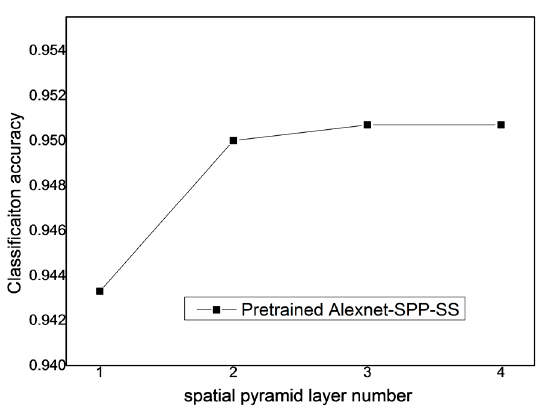
Figure 15. The influence of the spatial pyramid number for the pre-trained AlexNet-SPP-SS model with the Google Image dataset of SIRI-WHU.